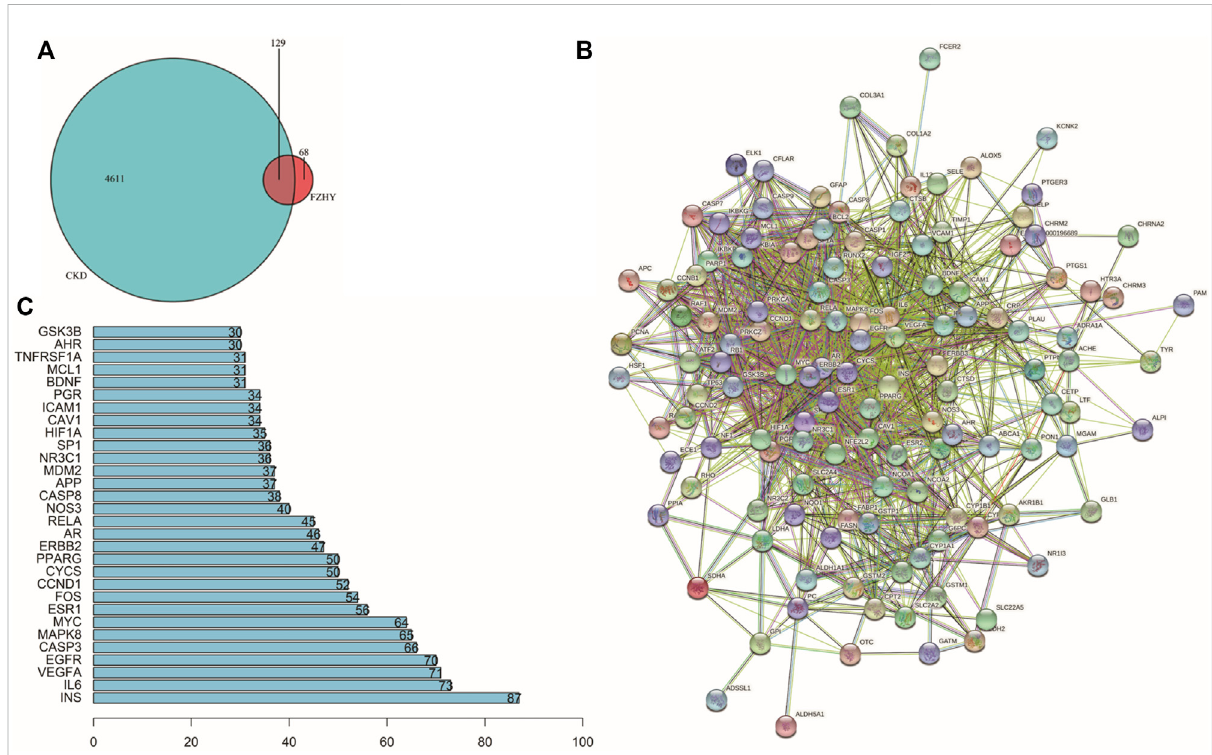
FIGURE 2 Construction of PPI network. (A) Venn diagram of 129 target genes of Fuzheng Huayu (FZHY) and chronic kidney disease (CKD). Overlaps are considered potential target genes of FZHY acting on CKD. (B) Protein – protein interaction network constructed using STRING. (C) Bar plot of potential hub proteins. Y -axis represents name of the protein. X -axis represents number of adjacent proteins. Height denotes the number of protein